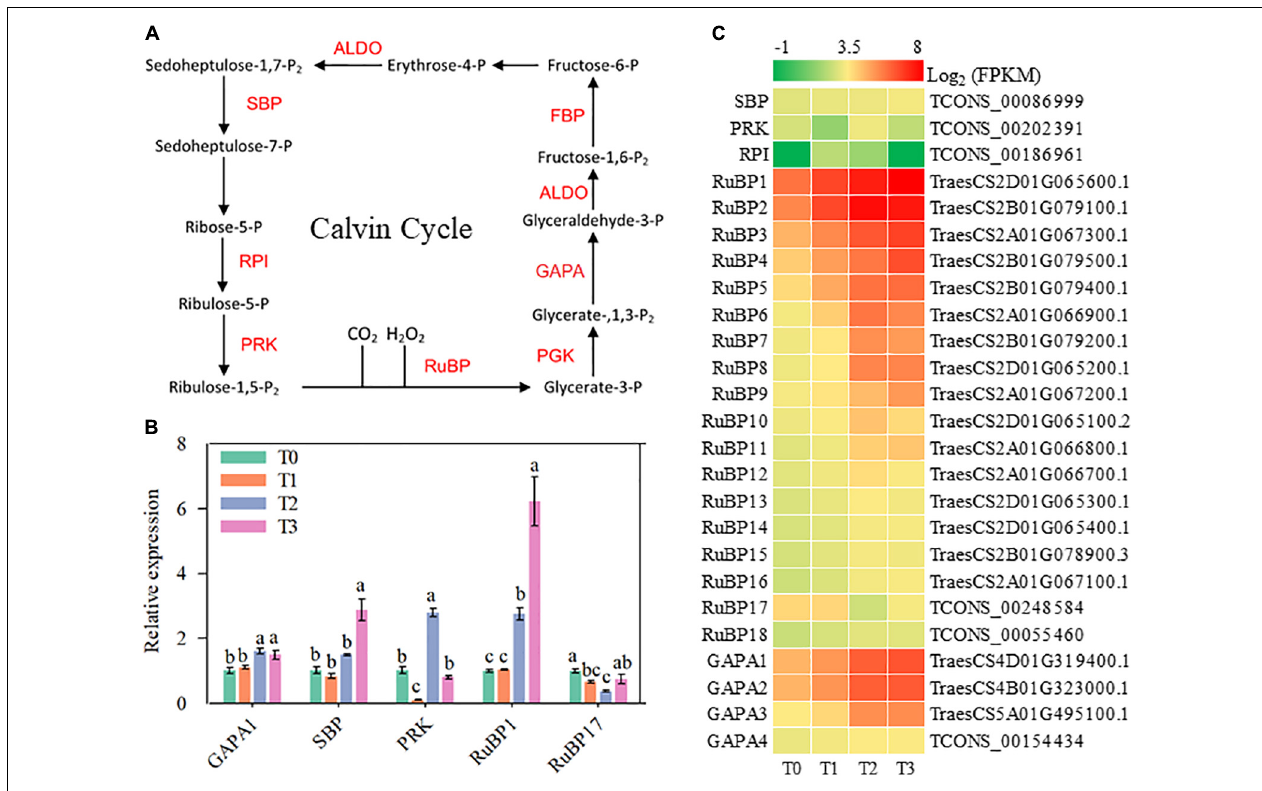
FIGURE 8 | Genes involved in carbon fixation and malate metabolism. ALDO, fructose-bisphosphate aldolase; FBP, fructose-1,6-bisphosphatase; GAPA, glyceraldehyde-3-phosphate dehydrogenase; PGK, phosphoglycerate kinase; RuBP, ribulose bisphosphate carboxylase; PRK, phosphoribulokinase; RPI, ribose-5-phosphate isomerase; SBP, sedoheptulose-1,7-bisphosphatase. (A) Pathway map of carbon fixation and malate metabolism. (B) Verification of the expression of some genes in the pathway. Data are the mean values of four independent replicates ( n = 4), and error bars show the standard error. Duncan’s multiple-comparison test was used for ANOVA, and different lowercase letters indicate a significant difference at the level of P < 0.05. (C) Heatmap of differentially expressed mRNAs in this pathway. T0, T1, T2, and T3 means the sample was harvested at 0, 2, 24, and 72 h after mowing,